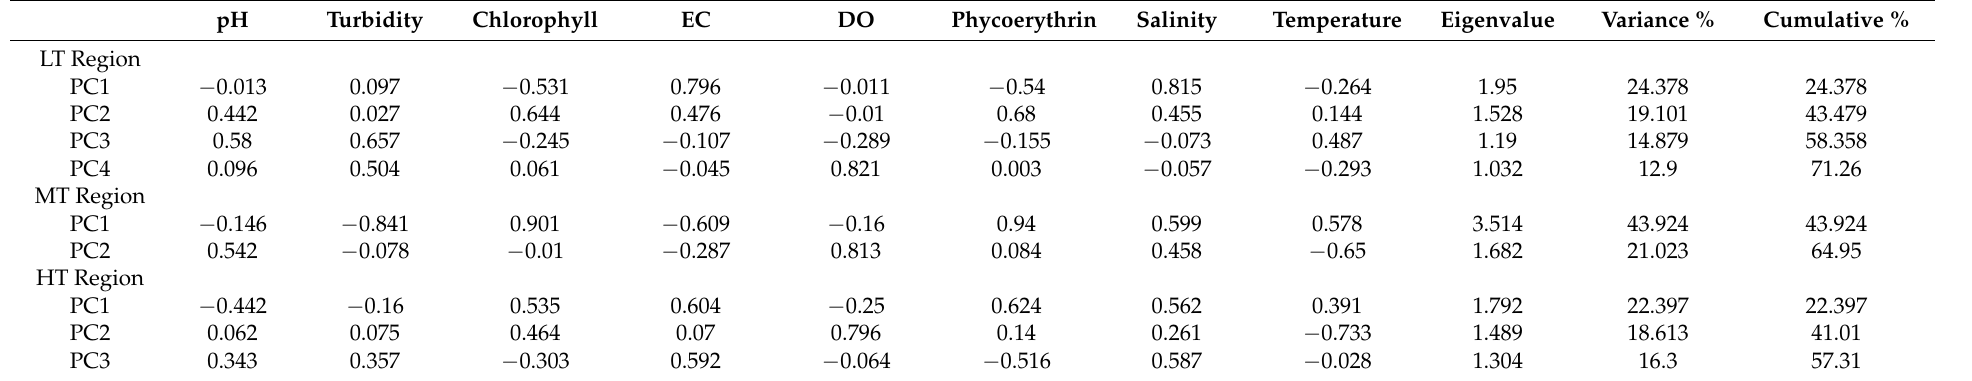
Table 4. Loadings of experimental variables (8) on significant principal components for low turbidity (LT), medium turbidity (MT), and high turbidity (HT)